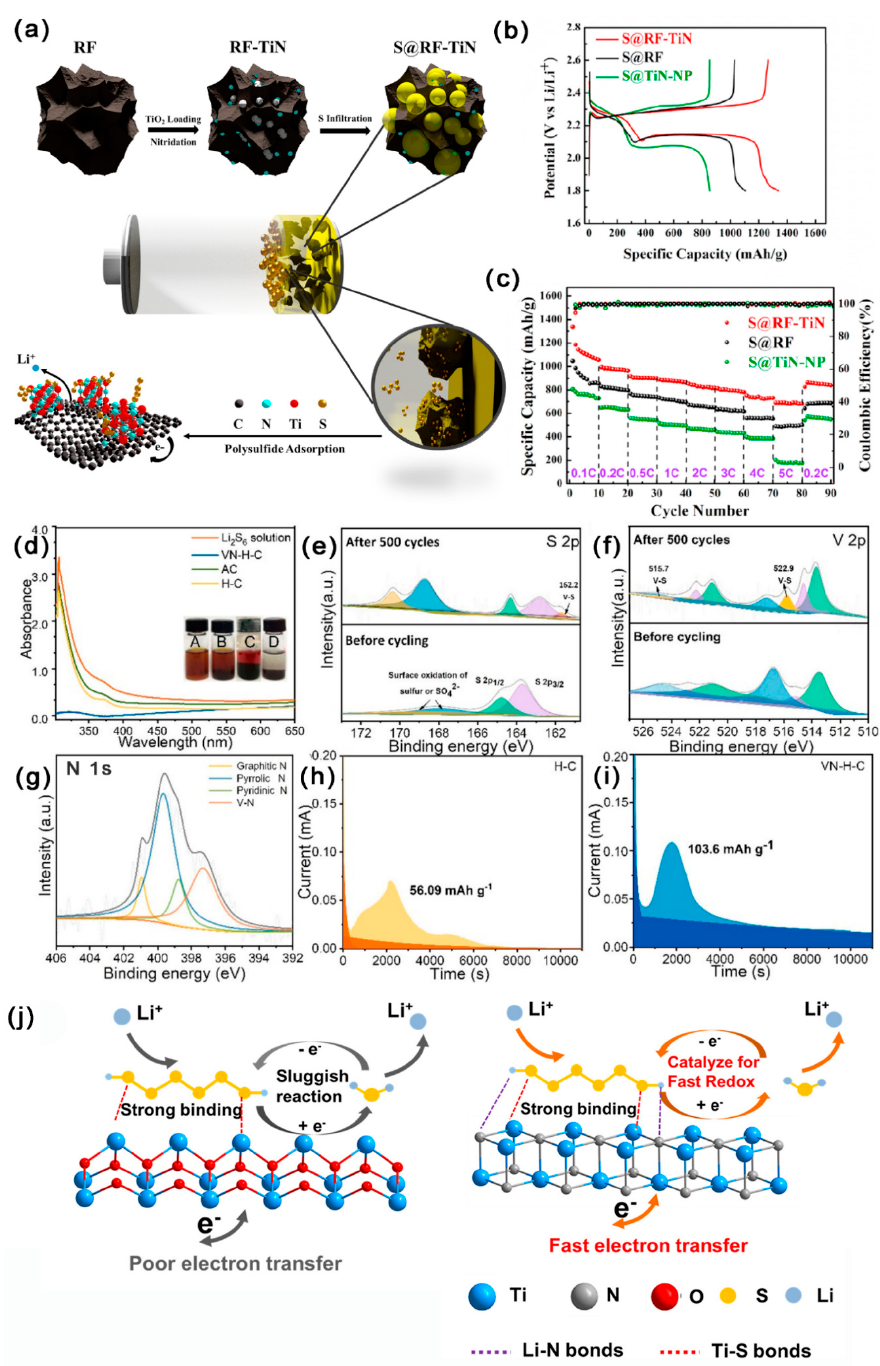
Figure 16. ( a ) Schematic diagram of the preparation of S@RF-TiN. ( b ) galvanostatic charge and discharge potential profiles of S@RF-TiN at 0.1 C. ( c ) Rate performance for S@RF-TiN (0.1 C–5 C) [110]. ( d ) Visual adsorption experiments on a Li 2 S 6 electrolytes after adding MoS 2 − X /HMC, ( e ) S 2p, ( f ) V 2p and ( g ) N 1s XPS spectra of S@VN-H-C before and after 500 cycles. ( h , i ) Li 2 S 8 and tetraglyme solution potentiostatic discharge pa tt erns on VN-H-C surfaces at 2.05 V (The upper light-colored region represents the deposition of Li 2 S) [111]. ( j ) Diagram demonstrating the conversion and adsorption of LiPSs on the TiN [112].